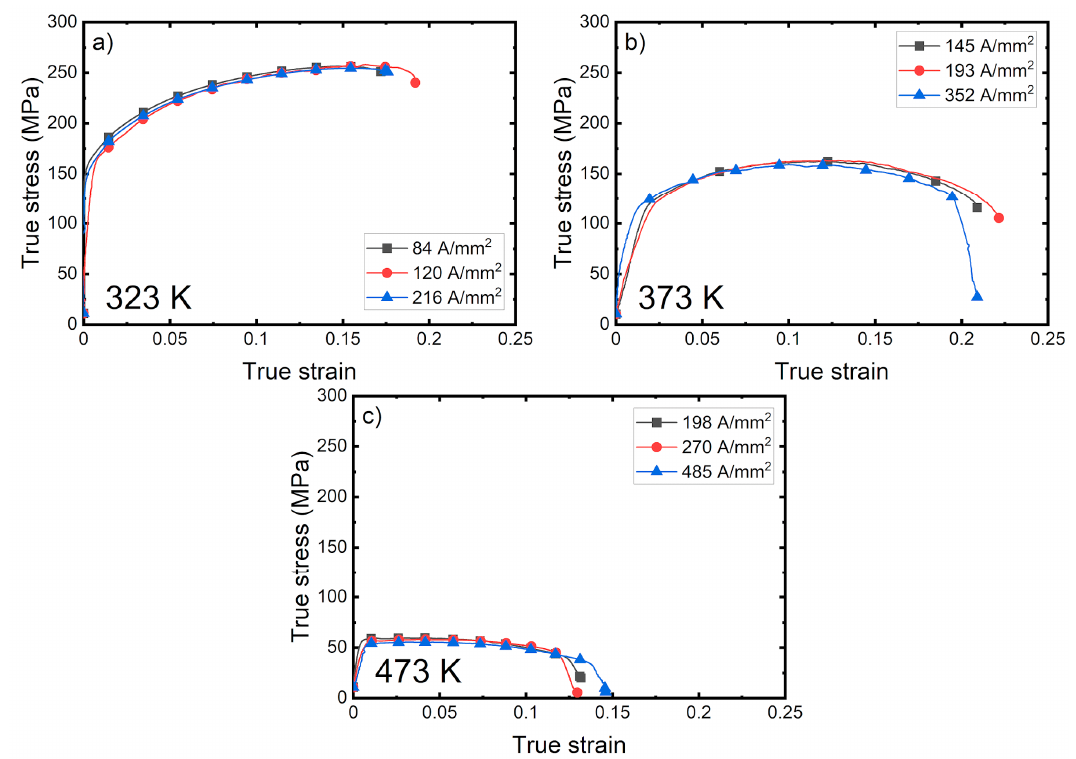
Figure 7. True stress–strain curve for ( a ) 323 K, ( b ) 373 K, and ( c ) 473 K.